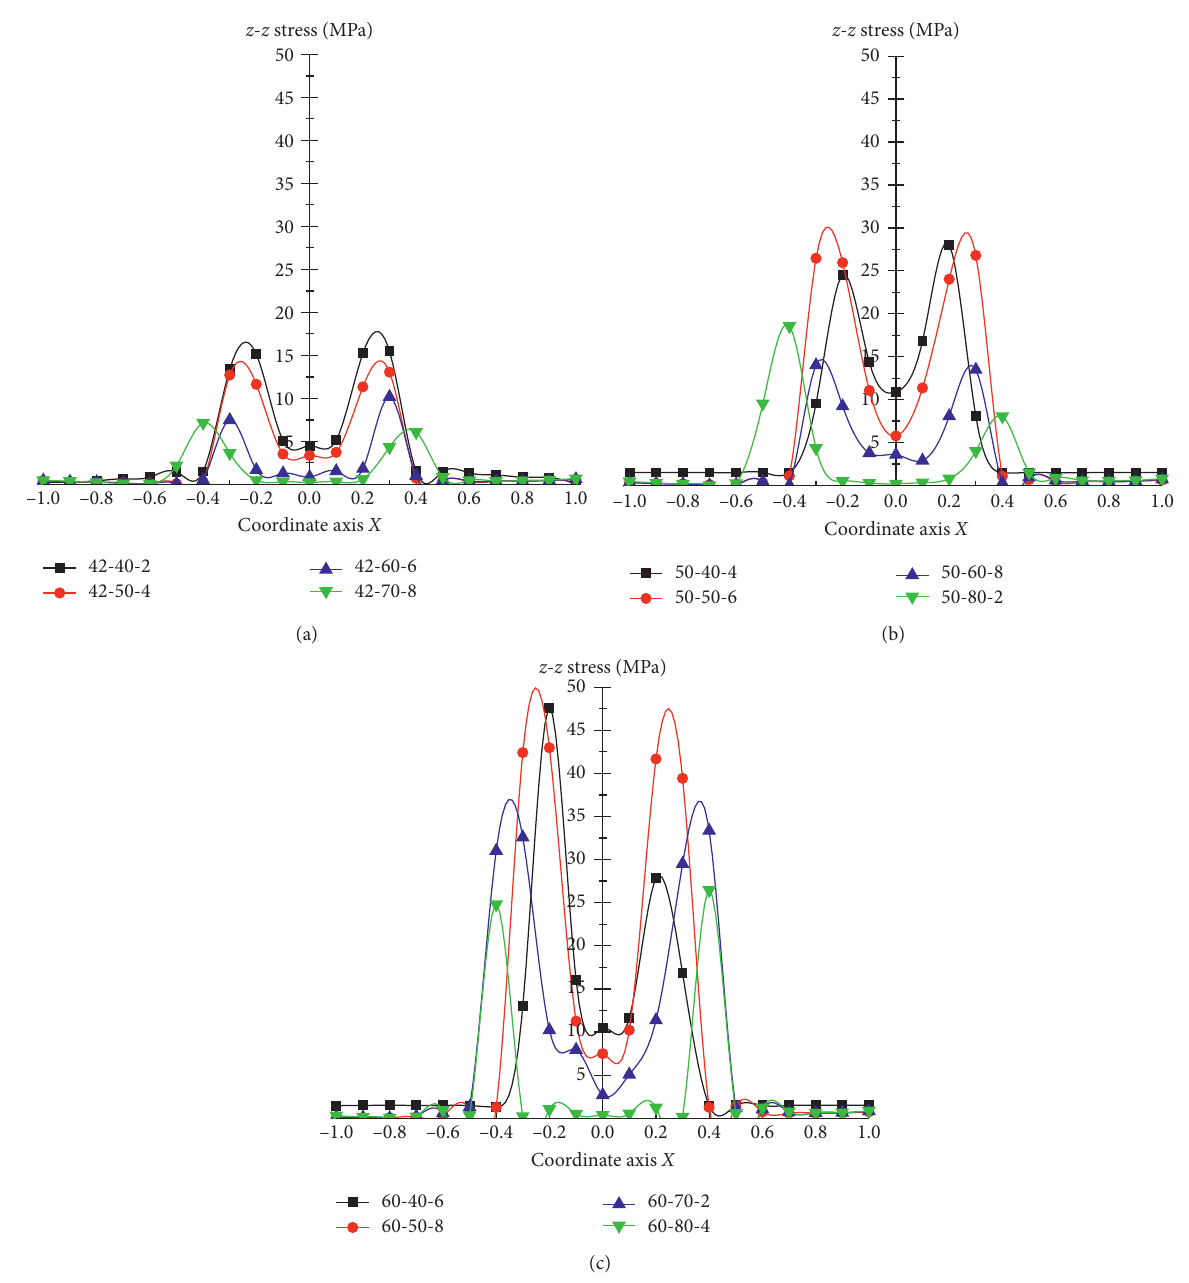
Figure 11: Z – Z stress distribution along connecting line of holes: (a) 42, (b) 50, and (c) 60mm hole